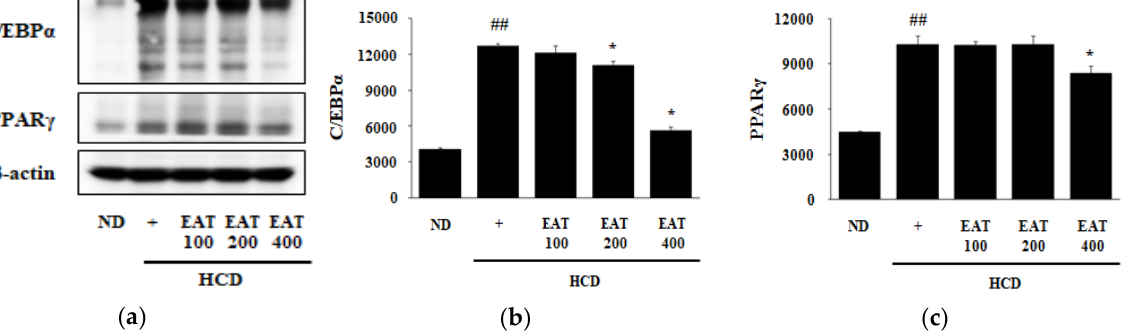
Figure 5. Effect of EAT on protein expression of PPAR-γ and CEBP-α in an HCD-induced C57BL/6 mouse model. ( a – c ) To measure the adipogenesis of liver induced by HCD, the expression of PPAR-γ and CEBP-α was determined by Western blot and the representation of PPAR-γ and CEBP-α was analyzed by densitometry protocol. Values are expressed as mean ± SD; ## p < 0.01 compared with the ND group; * p < 0.05 compared with the HCD group.